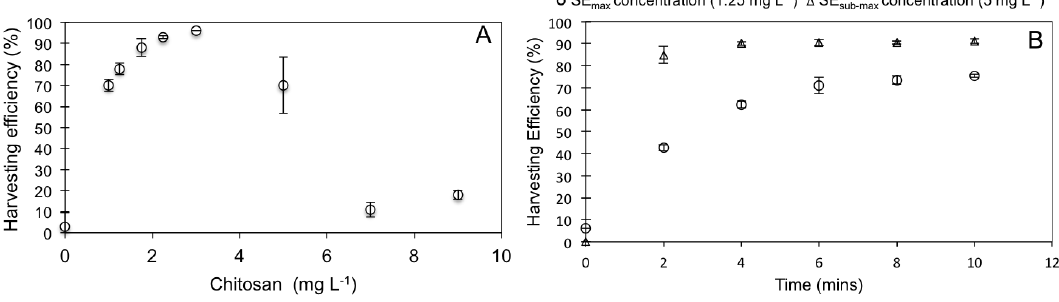
Figure 2. WRP sample tests ( A ) Sedimentation efficiency using chitosan ( B ) eFLOAT harvesting efficiency at SE max and SE sub-max chitosan concentrations.